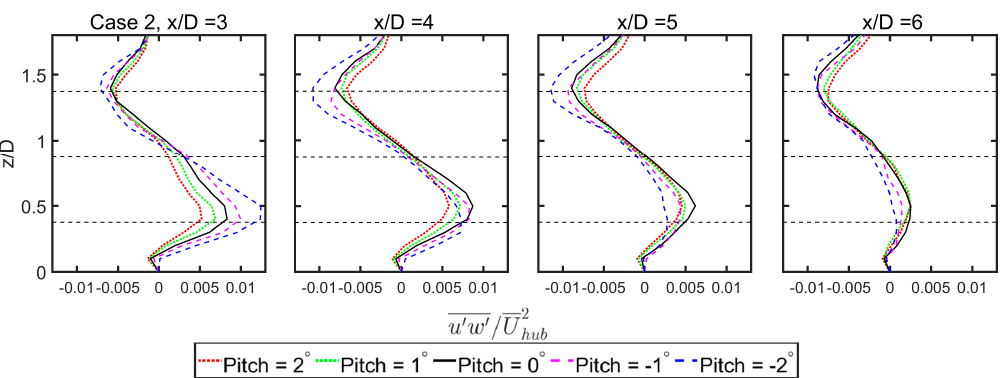
Figure 6. Vertical profiles of normalized vertical momentum flux at a plane through the turbine center, for a turbulence intensity of 4.3% ( top ) and 6.3% ( bottom ) for the incoming flow. Energies 2017 , 10 , 757 Here, I u is the total turbulence intensity, I u,inflow is the turbulence intensity from the inflow and I u,add is the added turbulence by the turbine. The normalized vertical turbulent flux, defined as (cid:3048)(cid:4593)(cid:3050)(cid:4593)(cid:3364)(cid:3364)(cid:3364)(cid:3364)(cid:3364)(cid:3364)(cid:3364) , (cid:3022)(cid:3365) (cid:3283)(cid:3296)(cid:3277)(cid:3118) , indicate the momentum flux from the and normalized lateral turbulent flux, defined as (cid:3048)(cid:4593)(cid:3049)(cid:4593)(cid:3364)(cid:3364)(cid:3364)(cid:3364)(cid:3364)(cid:3364) (cid:3022)(cid:3365) (cid:3283)(cid:3296)(cid:3277)(cid:3118)